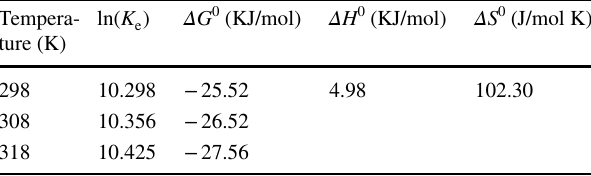
Table 2 Values of different thermodynamic parameters